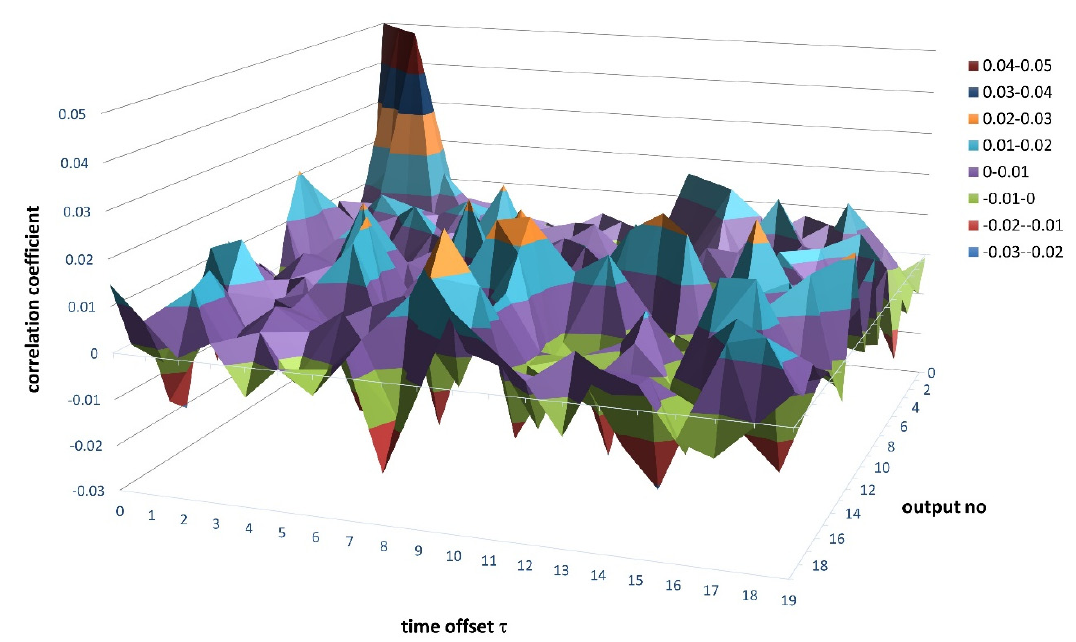
Figure 10. The graph for the correlation coefficient for the DT-LFSR with the D 3 T 17 structure—the zoomed-in picture for correlation coefficient range from –0.03 do +0.05, the correlation coefficient was calculated for a test sequence with the length of 10,000 vectors.